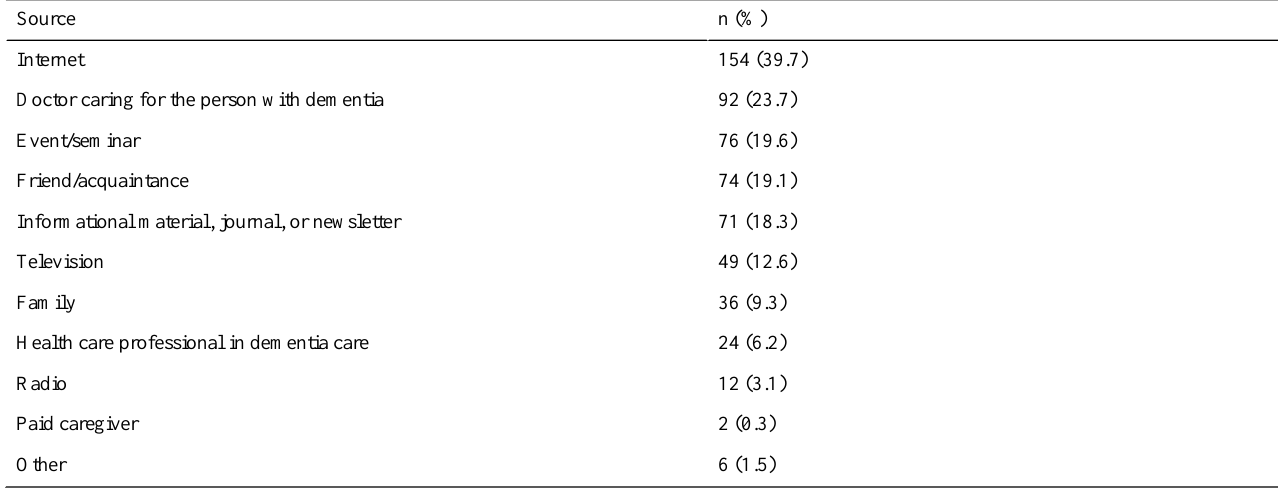
Table 2. Source of information about available dementia services (N=388 a ).